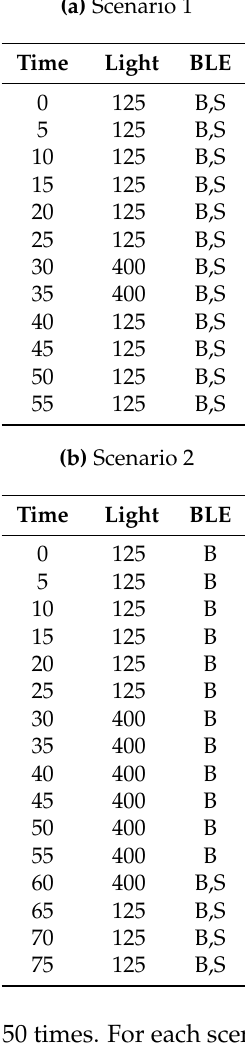
Table 3. Overview of the observed values of the light sensor and the BLE sensor at each timestamp, for scenarios 1 and 2. The timestamps are in seconds since the start of the scenario, the light values in lumen, and for the BLE values, ’B’ represents an observation of the BLE bracelet assigned to Bob, and ’S’ similarly for Susan’s bracelet. Changes to observed values only occur on multiples of 5 s. Note, however, that the light sensor samples every second, and the BLE sensor every 5